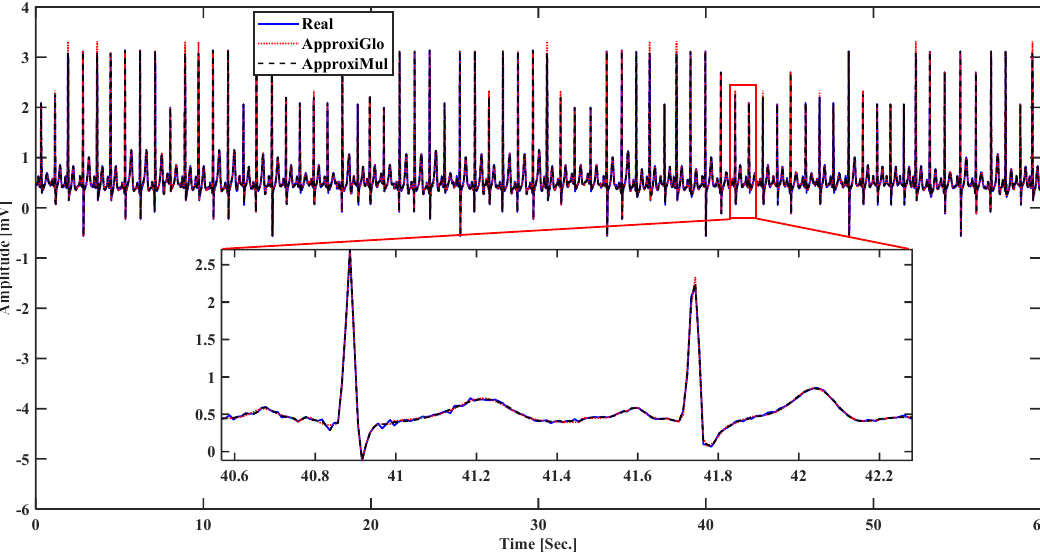
Figure 6. Model fitting on a 1-min ECG collected from UCDSA.